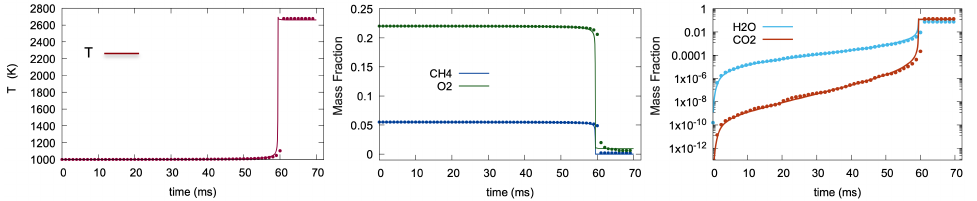
Figure 8. Mean absolute error of LIT prediction compared to OpenFOAM data. Normalized output quantities [0–1] are used in this plot. Standard deviation of error is plotted too.